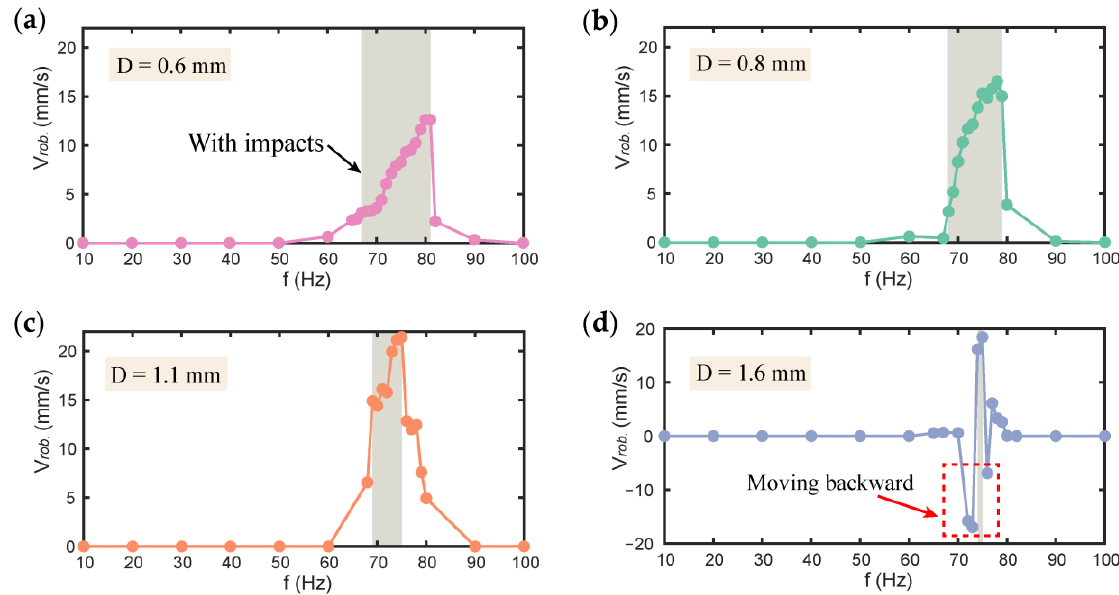
Figure 9. ( a ) The velocity of the robot with constraint gap of 0.6 mm; ( b ) The velocity of the robot with constraint gap of 0.8 mm; ( c ) The velocity of the robot with constraint gap of 1.1 mm; ( d ) The velocity of the robot with constraint gap of 1.6 mm.